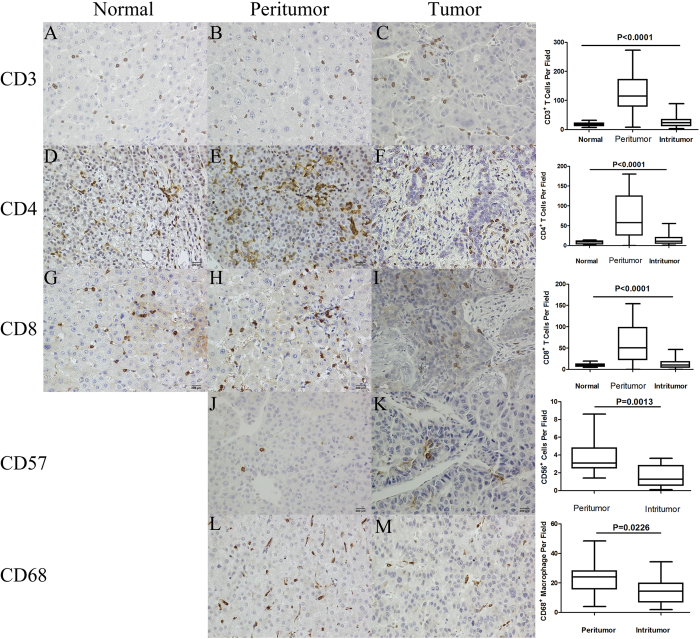
Immunohistochemistry figures of CD3, CD4, CD8, CD57 and CD68.